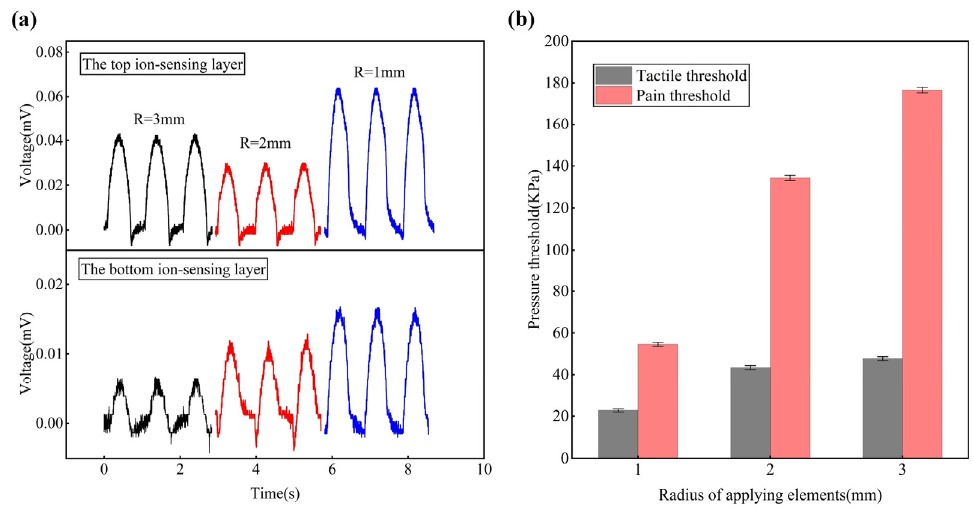
Figure 8. The experimental results. ( a ) Effect of applying elements with different radius on voltage response of artificial receptor. ( b ) The pressure threshold of artificial receptors when the radius of the contact circle increases from 1 mm to 3 mm.